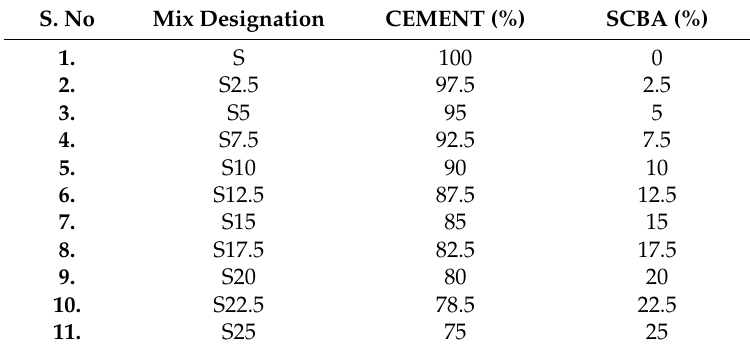
Table 1. Mix designation for Sugar cane bagasse ash (SCBA).